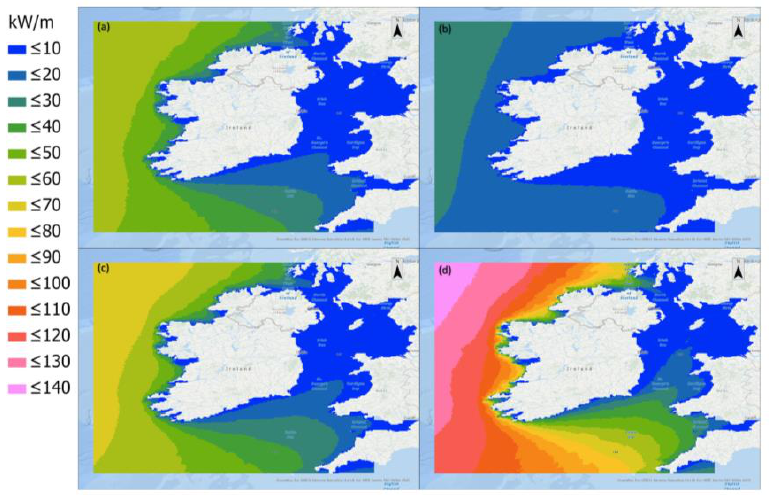
Figure 9. The seasonal mean wave power resource in kW per linear metre of wave crest for ( a ) spring, ( b ) summer, ( c ) autumn and ( d ) winter. ( b ) summer, ( c ) autumn and ( d ) winter.